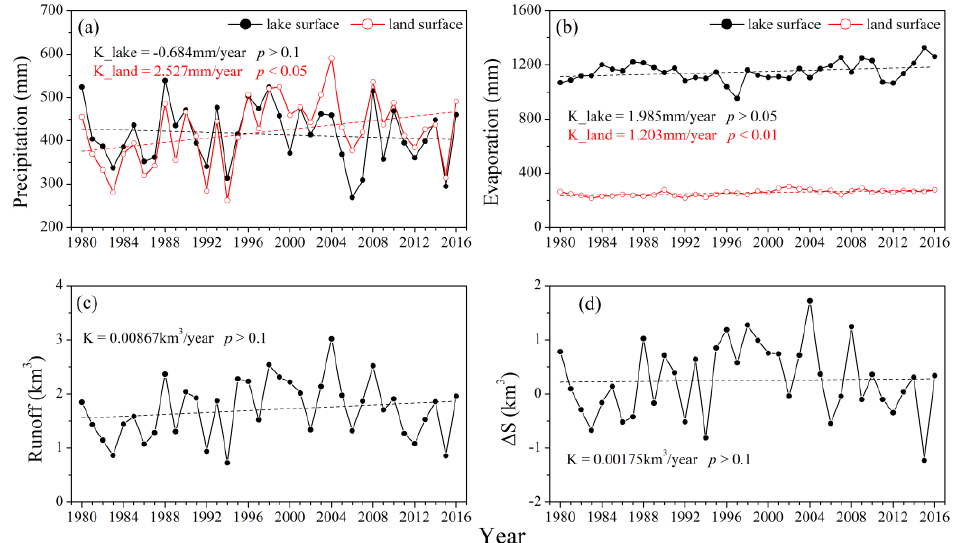
Figure 8. Variations in ( a ) annual precipitation, ( b ) evapotranspiration, ( c ) total runoff, and ( d ) lake water storage during 1980–2016.